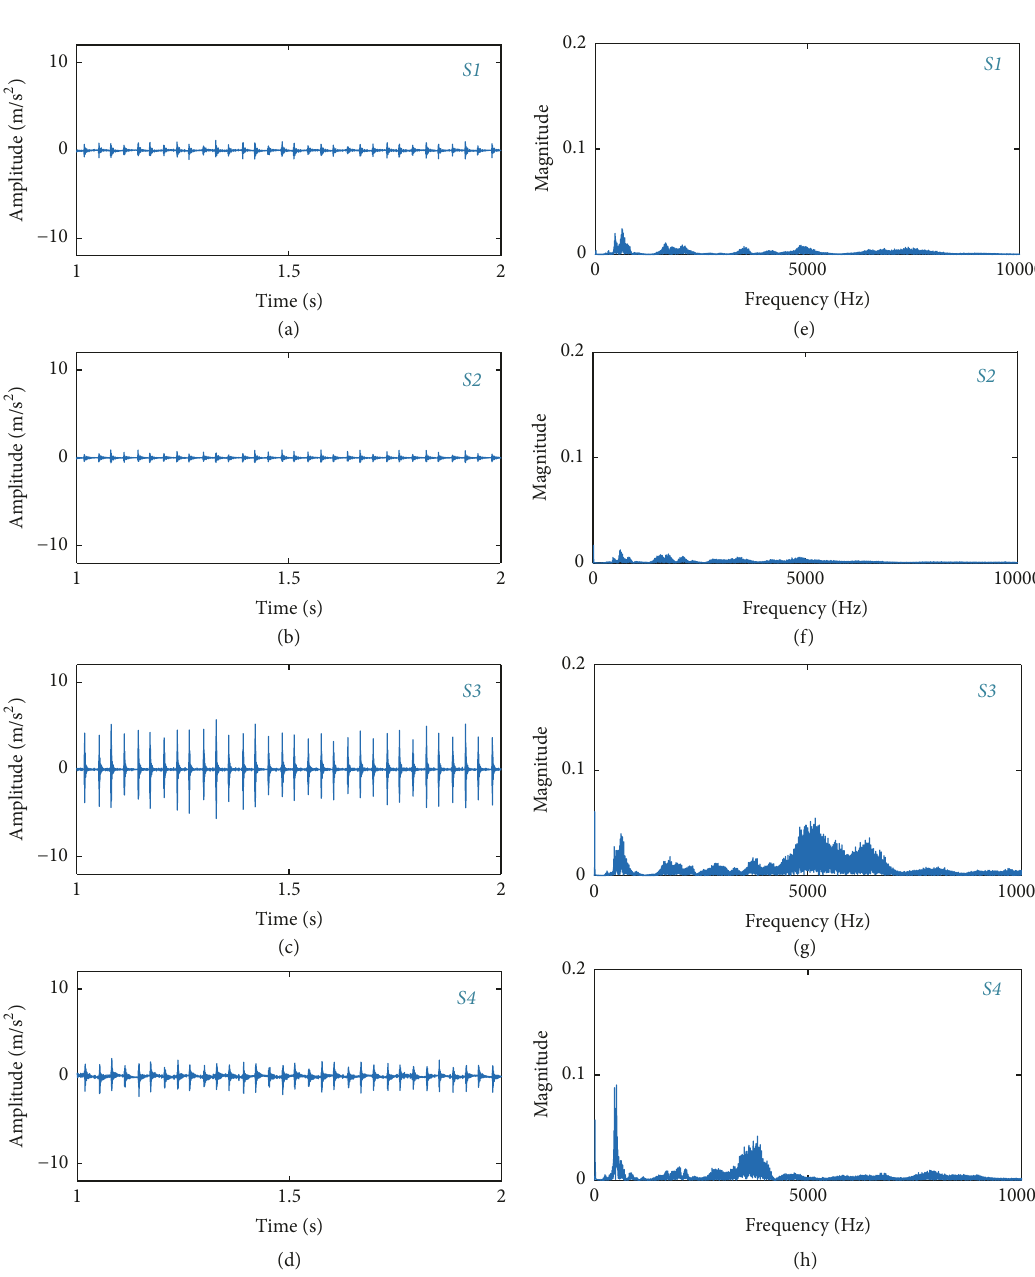
Figure 7: Case study 1: the captured time domain vibration signals from S1 to S4 in (a) to (d), respectively, and their corresponding spectrums in (e) to